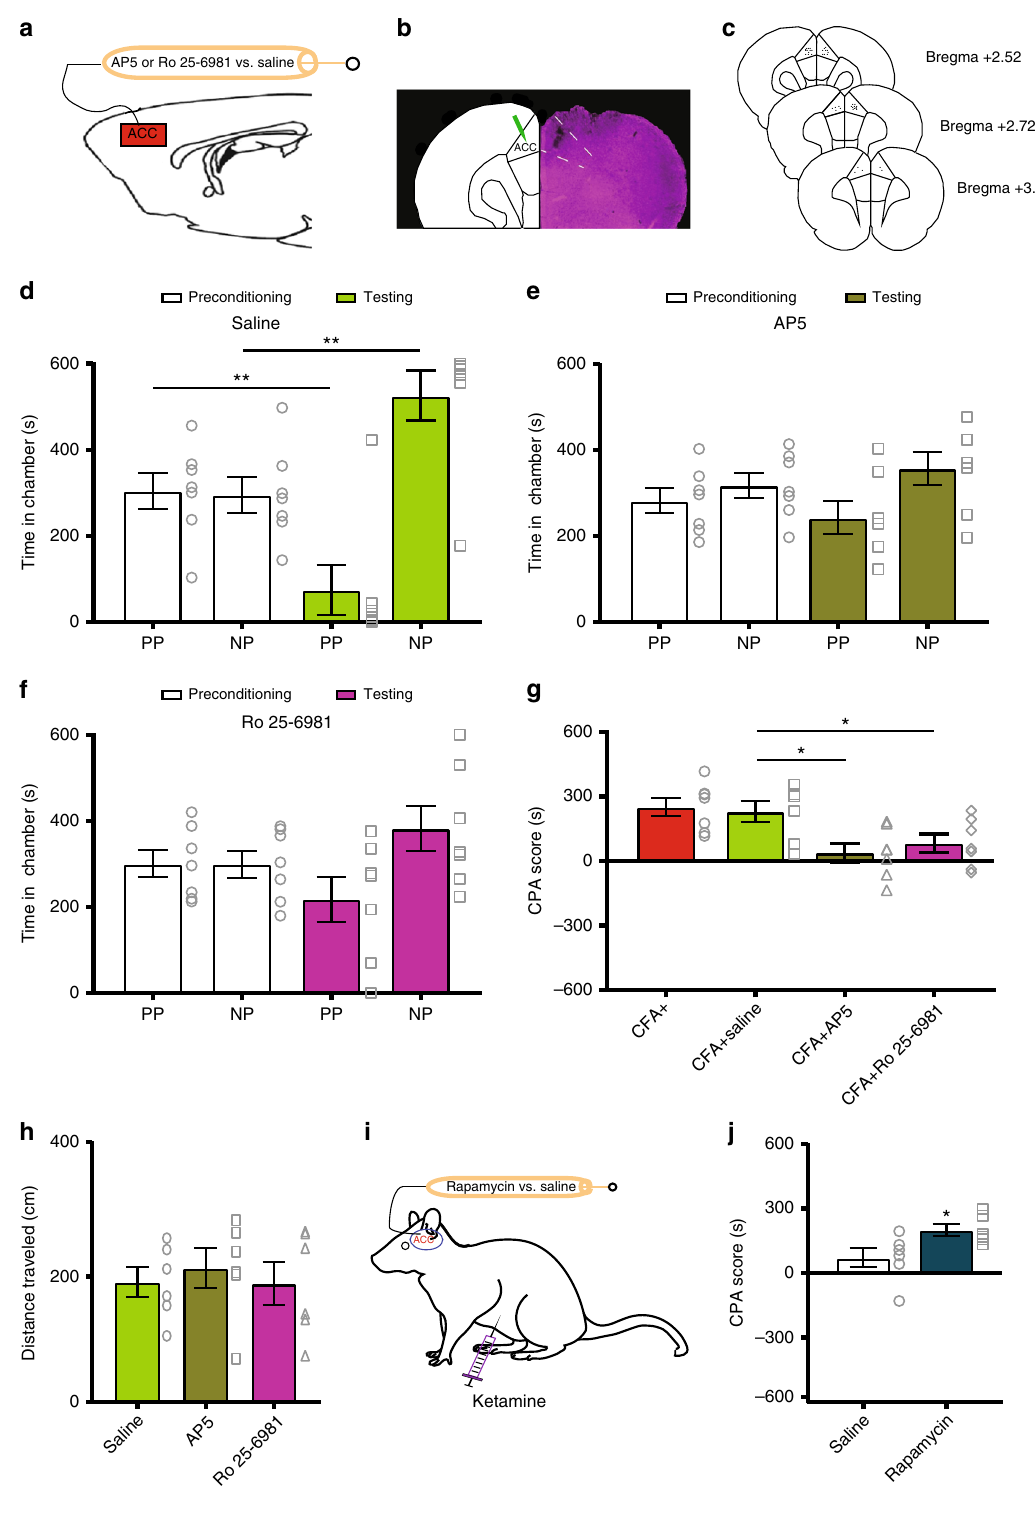
receptors in ACC neurons mediate the anti-aversive effects of ketamine, we injected AP5, a selective blocker of NMDA receptors, in the ACC of CFA-treated rats (Fig. 7a – c). Intra- stimulation in the chronic pain state (Fig. 7d, e). To further demonstrate the speci fi city of the NMDA receptor block, we administered an inhibitor for NR2B receptors, Ro 25-6981. Our